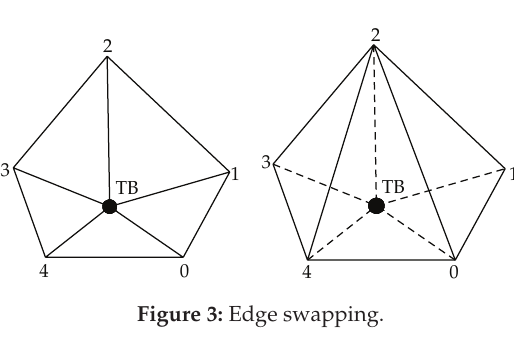
Figure 3: Edge swapping.